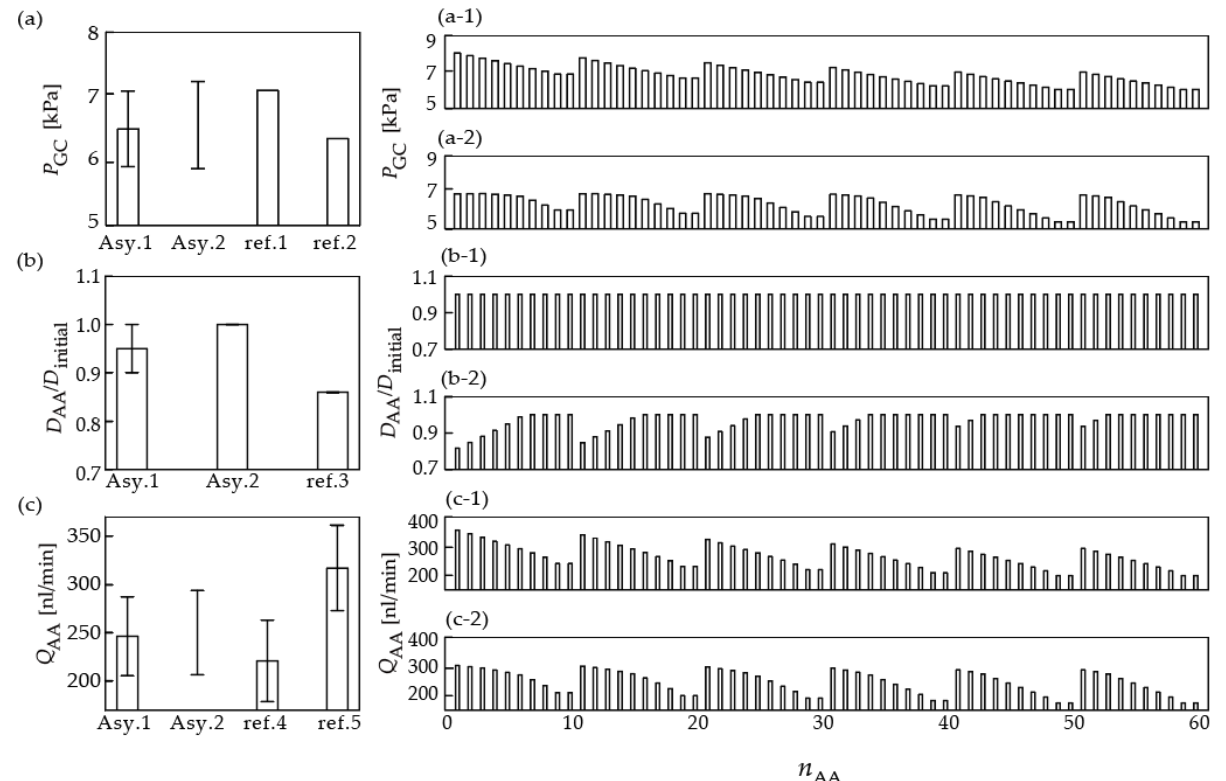
Figure 6. ( a ) Glomerular pressure, 𝑃 GC , ( b ) rate of change in AA diameter, 𝐷 AA /𝐷 initial , and ( c ) AA flow rate, 𝑄 AA , of the asymmetrical model with the myogenic response (Asy. 1 ) and the asymmetrical model without the myogenic response (Asy. 2 ). Mean value and the detailed distribution of a group of AAs are illustrated in the left and right panels (( a-1 ), ( b-1 ) and ( c-1 ) of Asy. 1 ; ( a-2 ), ( b-2 ) and ( c-2 ) of Asy. 2 ), respectively. Details of the references denoted: Ref.1: Table 4 from Dilley et al. [35]; Ref.2: Table 2 from Tucker and Blantz [36]; Ref.3: Figure 3 from Loutzenhiser et al. [39]; Ref.4: Kallskog et al. [3]; Ref.5, Table 2 from Yarger et al. [4].